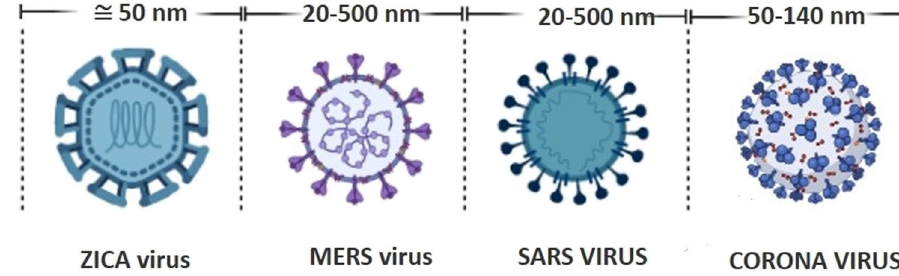
Figure 5: Coronaviruses related size.